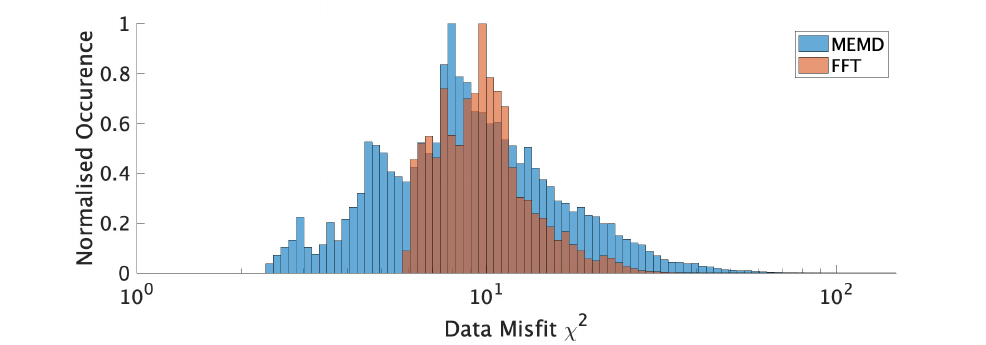
Figure 7. Weighted distribution of tested EJDN inversion models’ χ 2 for FFT and MEMD curves. It can be appreciated that MEMD generally achieved a lower (approximately factor 2 on average) data misfit during most inversions. The HVSR forward computations, the best standard deviation σ l are shown in Figure 8 , and in Tables 3 and 4.